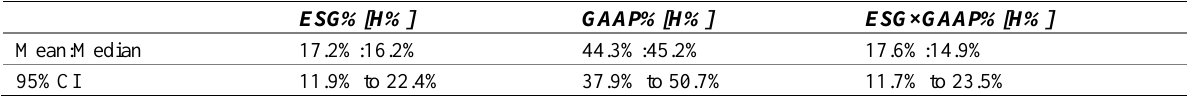
Table 4: Accrual Profiles and